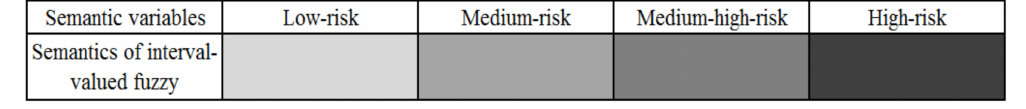
Figure 3. Schematic diagram of risk assessment scale.